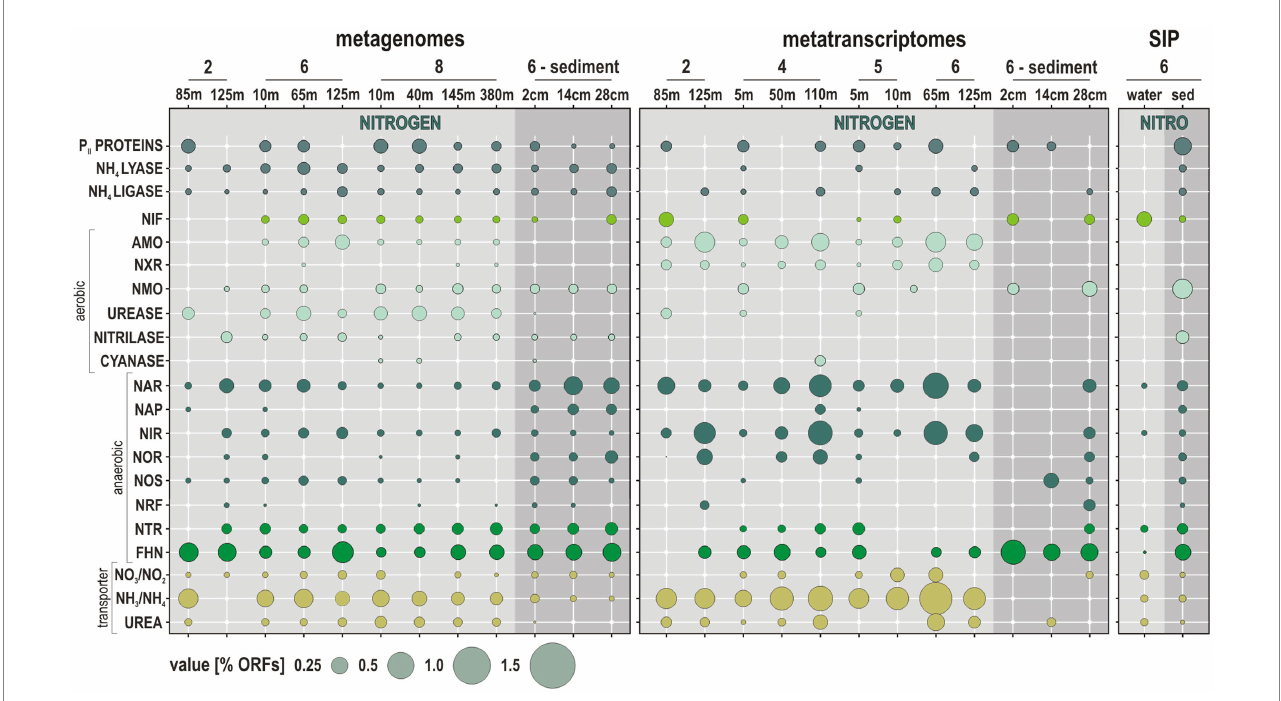
FIGURE 4 Metabolic potential and activities related to nitrogen cycling along the Namibian coast. Bubble plot showing the relative abundances of metabolic functions [% total ORFs] in the metagenomes, metatranscriptomes, and stable-isotope probing (SIP) sediment incubations (left to right) assigned to functional marker genes involved in nitrogen cycling. Abbreviations: P II PROTEINS: nitrogen regulatory proteins/NIF: nitrogen fixation/AMO: ammonium monooxygenase/ NXR: nitrite oxidoreductase/NMO: nitronate monooxygenase/NAR: nitrate reductase/NAP: periplasmic nitrate reductase/NIR: copper-containing nitrite reductase/NOR: nitric oxide reductase/NOS: nitrous oxide reductase/NRF: ammonia-forming cytochrome nitrite reductase/NTR: nitroreductases/FHN: formate